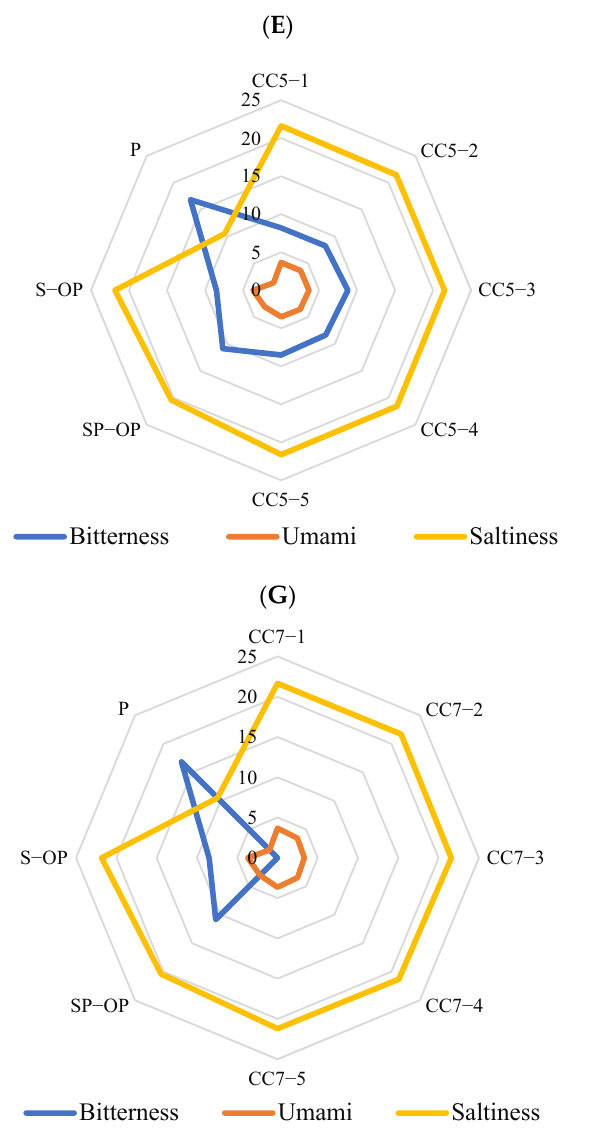
Figure 5. Analysis results of the additional experiment (( A ) addition experiment results of 5 ′ -GMP; ( B ) addition experiment results of malic acid; ( C ) addition experiment results of inosine; ( D ) addition experiment results of 5 ′ -AMP; ( E ) addition experiment results of guanosine; ( F ) addition experiment results of fumaric acid; ( G ) addition experiment results of 18 β -glycyrrhetinic acid).